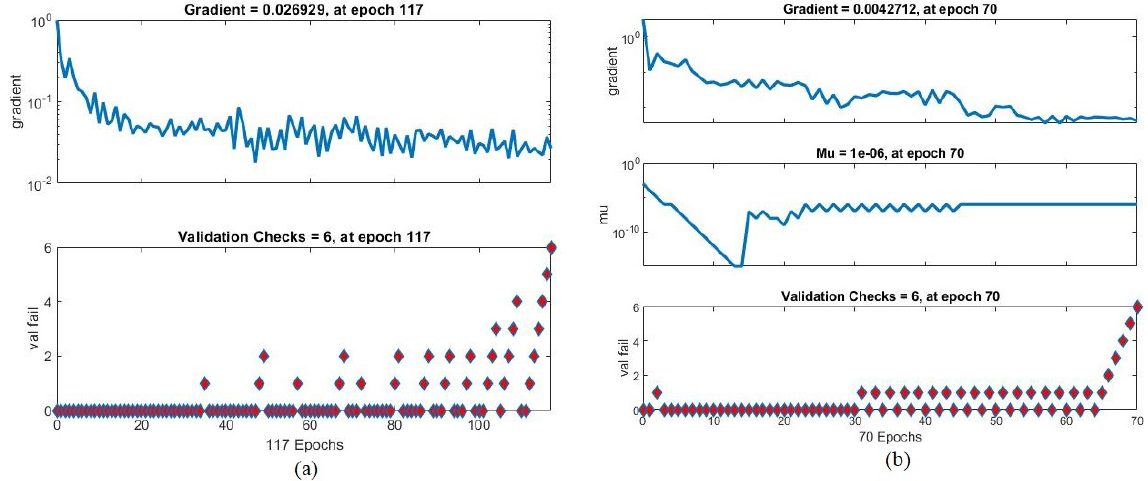
Figure 10. Gradient and validation measurement for the microscopic blood sample dataset produced using the ( a ) ANN algorithm and ( b ) FFNN algorithm.